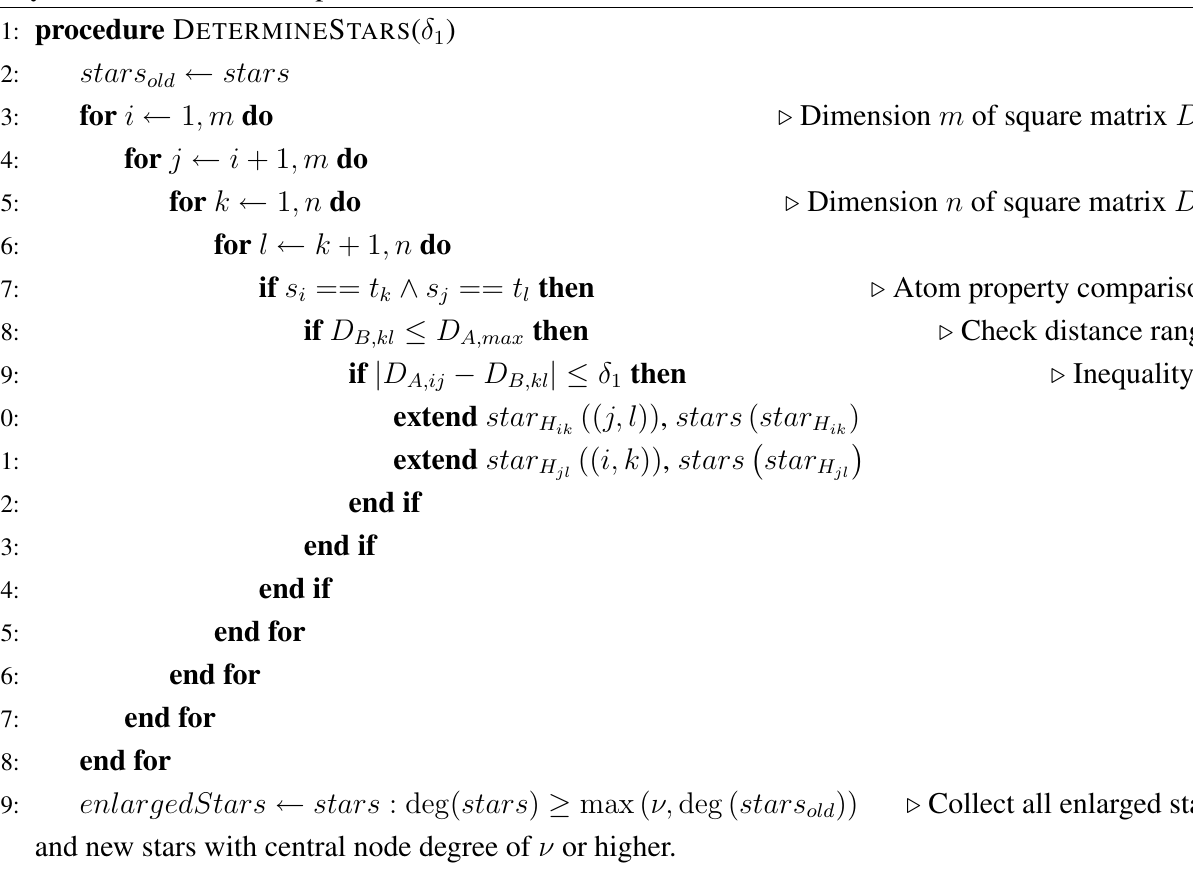
Algorithm 2 Pseudocode of Step 1 of E PITOPE M ATCH algorithm covering the determination of stars, i.e. the seed matches. If several condition are fulfilled, including Inequality 2 in line 9, the star graph around atoms i of A and k of B is extended by an edge to atoms j of A and l of B , and vice versa. Line 10 indicates that the star around i and k is addressed by hash key H entry in stars is then also